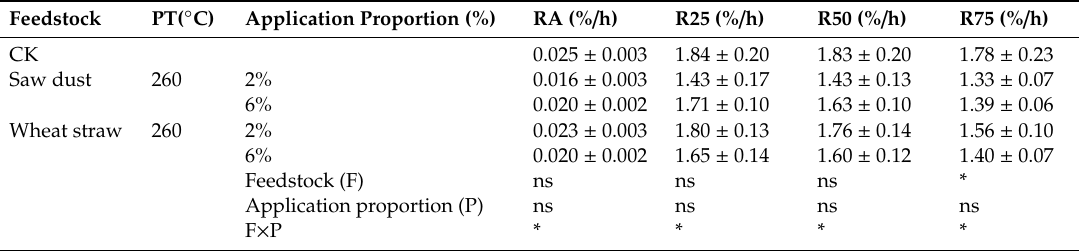
Table 4. Soil evaporation rate under treatments of two hydrochar (SHC260 and WHC260) and two application proportion (2% and 6%).